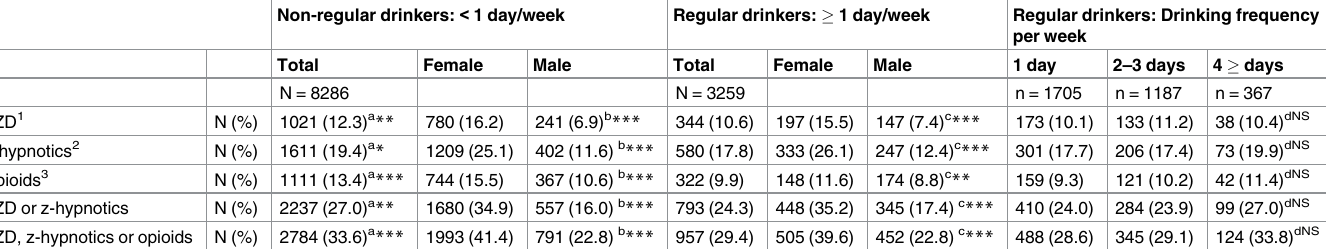
Table 2. Prevalence of use of benzodiazepines, z-hypnotics and opioids according to drinking status and drinking frequency in older Norwegian adults ( (cid:21) 65 years, N = 11,545). The HUNT Study 2006–08(HUNT3). Non-regular drinkers: < 1